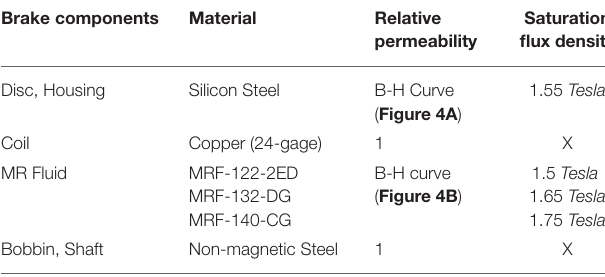
TABLE 1 | Magnetic property of the brake